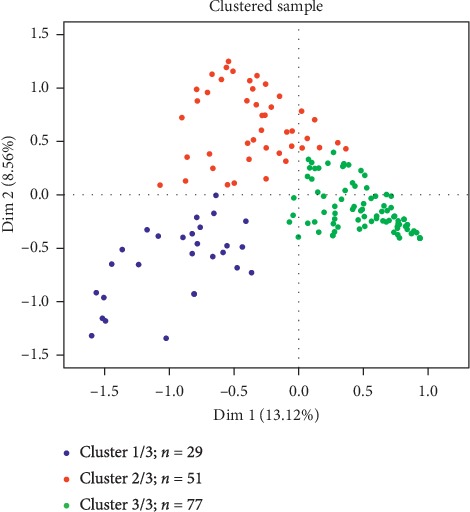
Cluster analysis according to the responses of family caregivers of PWP and PWD.